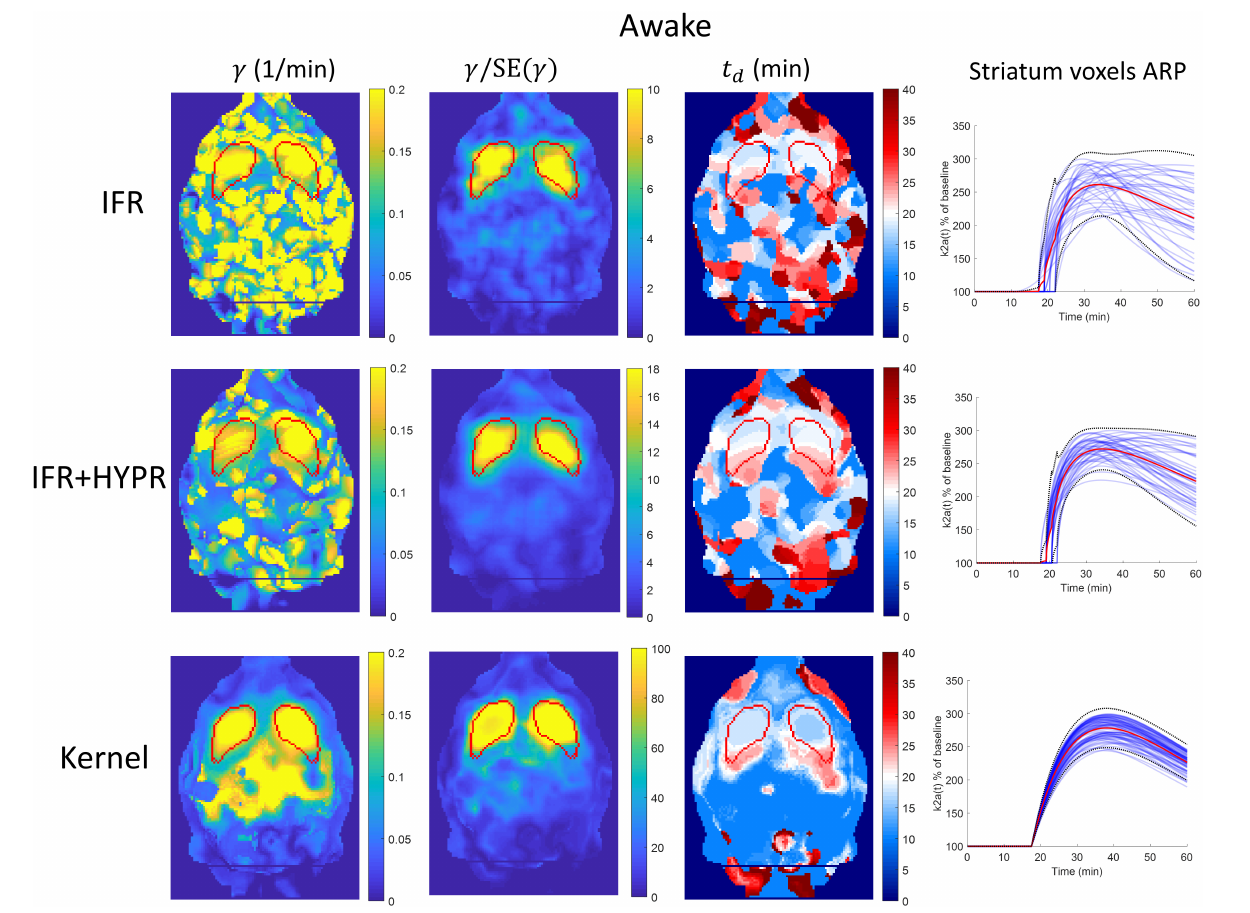
FIGURE 8 | Parametric γ , γ /SE( γ ) ( γ t-statistic), and t d brain maps, as well as activation response profiles (ARP) for striatum voxels, calculated using independent frame reconstruction (IFR, first row), independent frame reconstruction with HYPR denoising (IFR+HYPR, middle row), and spatiotemporal kernel reconstruction (Kernel, third row), for the awake rat scan. White regions in t d maps correspond to cold raclopride injection time (20 min). Striatum delineated from MRI template shown in